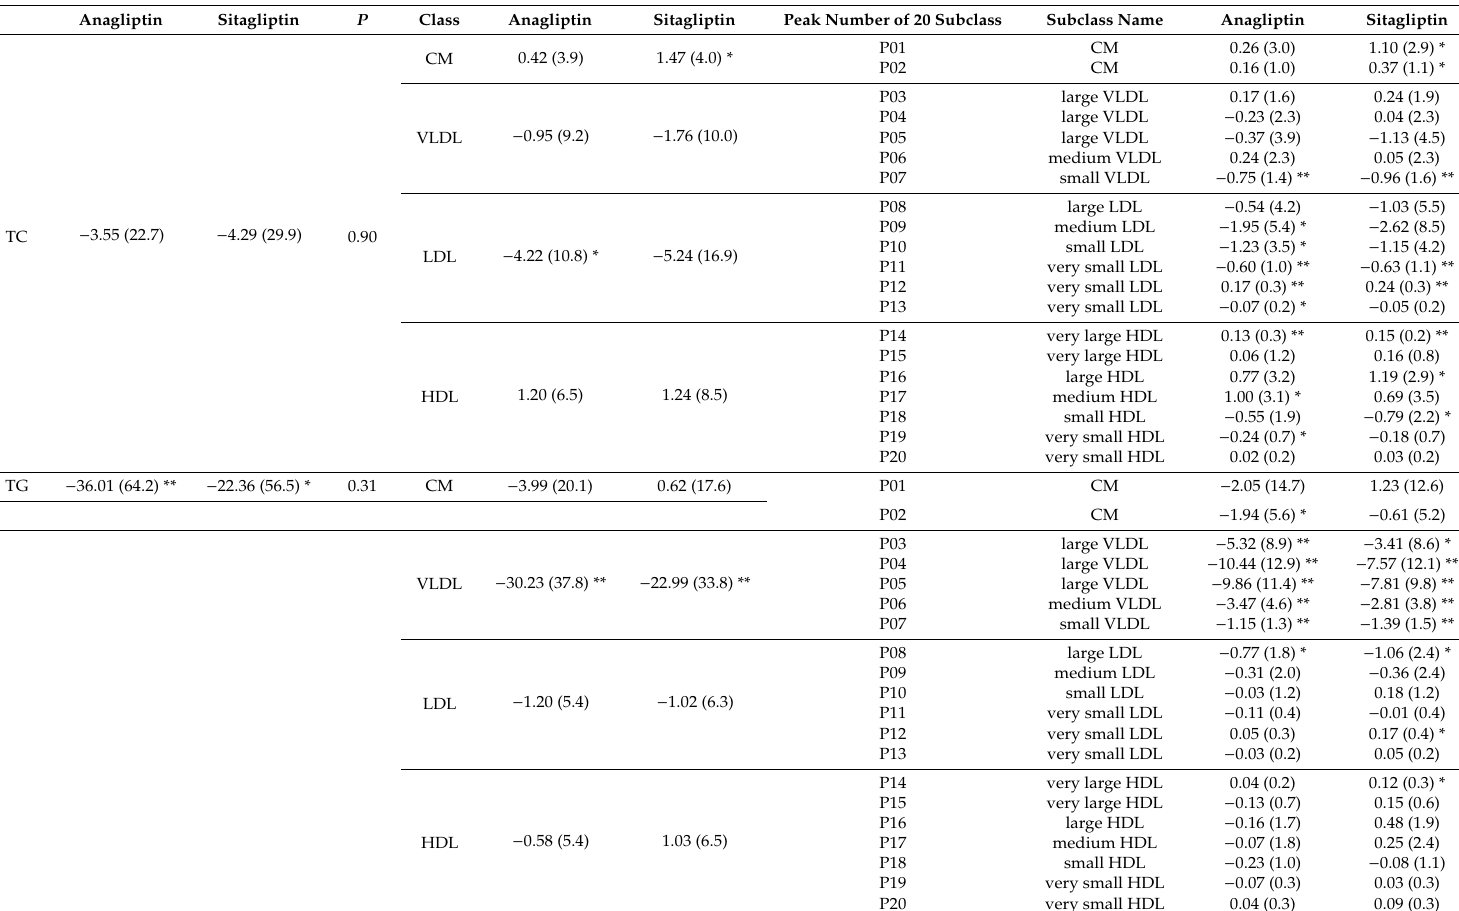
Table 4. Di ff erences in total cholesterol and triglycerides in lipoprotein classes and subclasses in patients treated either with anagliptin or sitagliptin. Strong statin